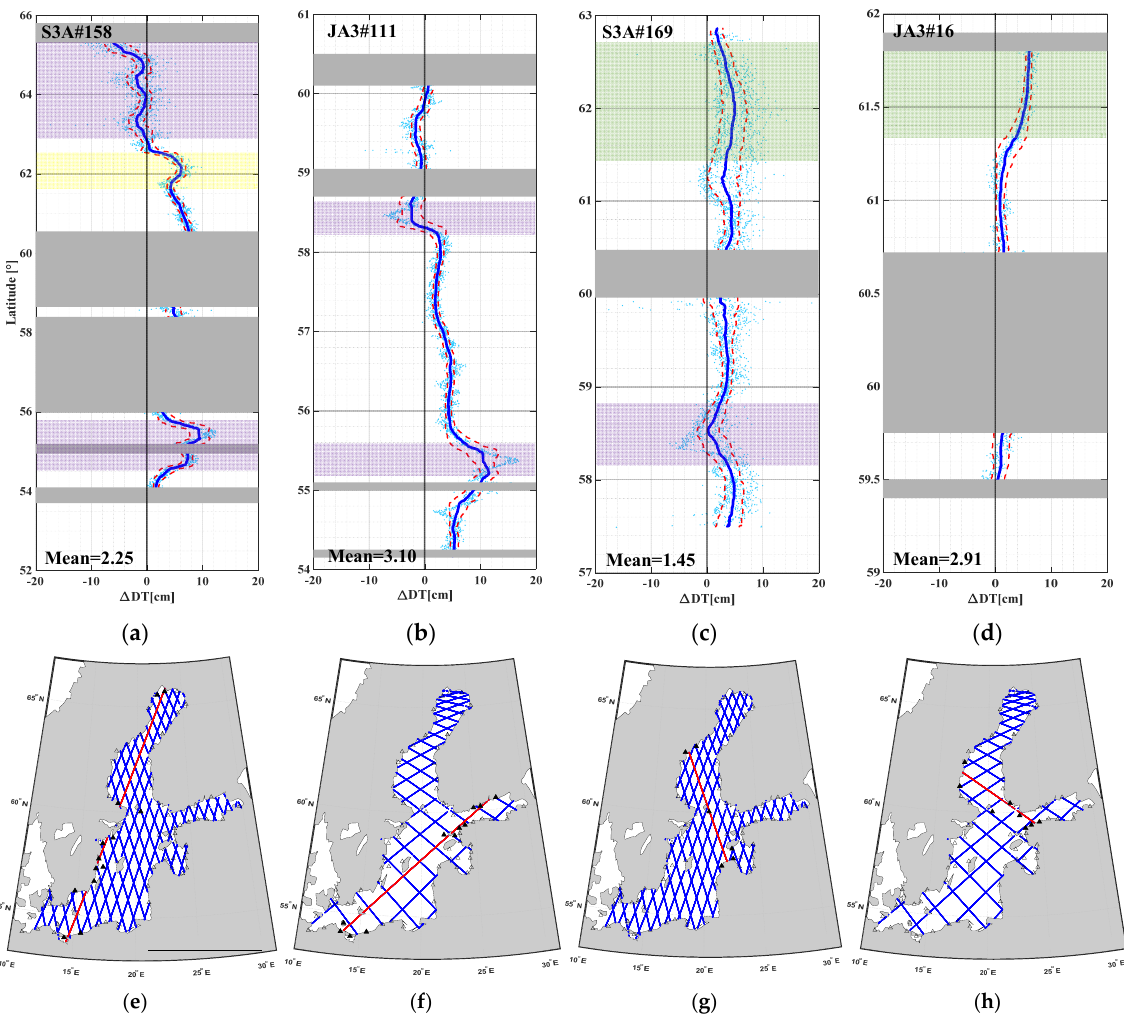
Figure 10. Along-track MEAN SA − HDM ( ϕ s , λ s ) for 4 SA passes (( a ): S3A#158, ( b ): S3A#169, ( c ): JA3#111, and ( d ): JA3#16) considering all available cycles during 2017–2019. The blue line represents the moving median of MEAN SA − HDM ( ϕ s , λ s ) and the dashed red lines represent the moving standard deviation “envelope”. The average of MEAN SA − HDM ( ϕ s , λ s ) is also denoted. The bottom row ( e – h ) represents each pass location in the Baltic Sea. The grey zone denotes masked land areas. The potential problematic areas are classified into three types. Yellow shaded regions: the suspected geoid model problems; green shade: TG records problem (or the HDM problem); purple shade: SA problem, possibly due to sea ice presence or land